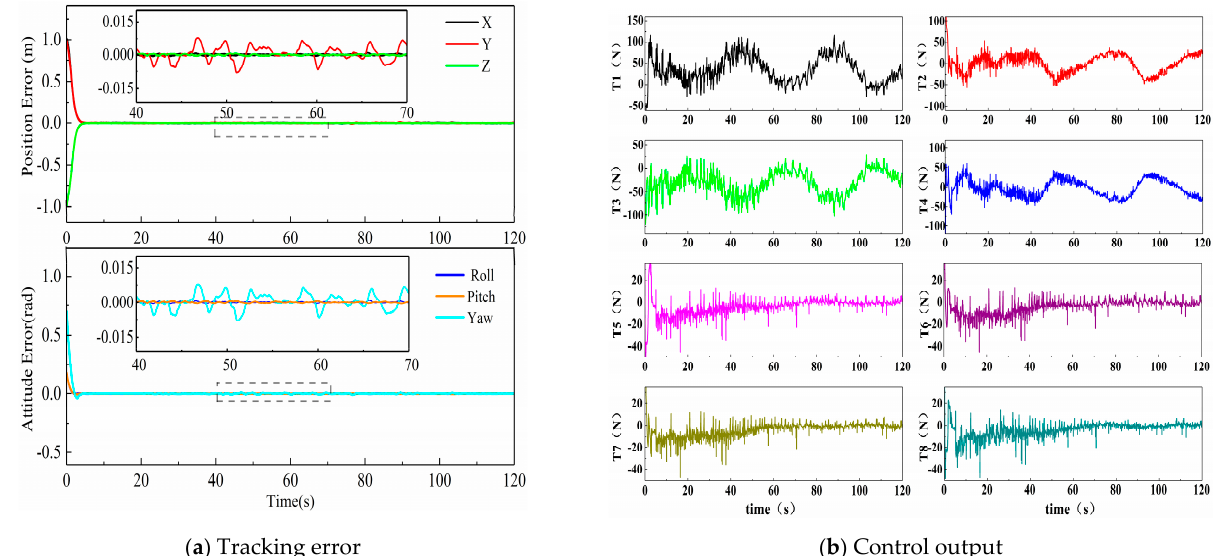
Figure 1. The control effect of FTESO − FTC − APAM under Case 1.